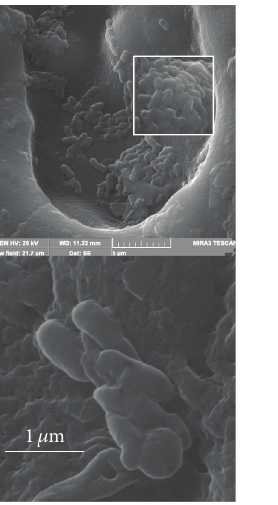
Figure 2: SEM micrographs of cross sections of alginate beads with probiotic cells, magnification 10000x.